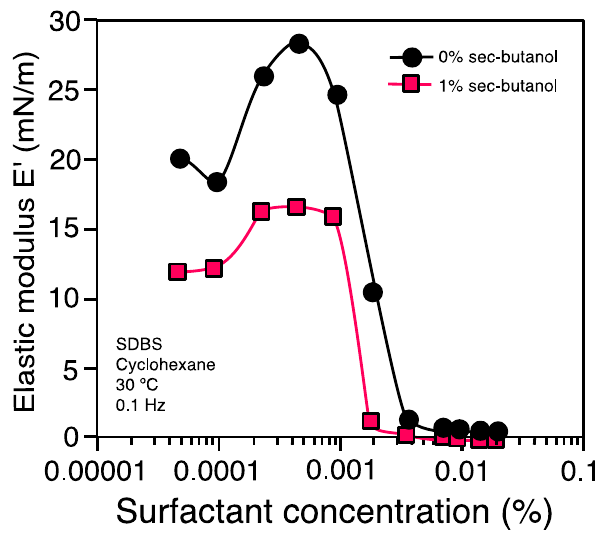
Figure 4. Storage modulus’ variation as a function of surfactant concentration in the SDBS-cyclohexane-brine system, with and without sec-butanol as co-surfactant. Frequency = 0.1 Hz. T = 30 °C. SDBS concentration 0.02%.